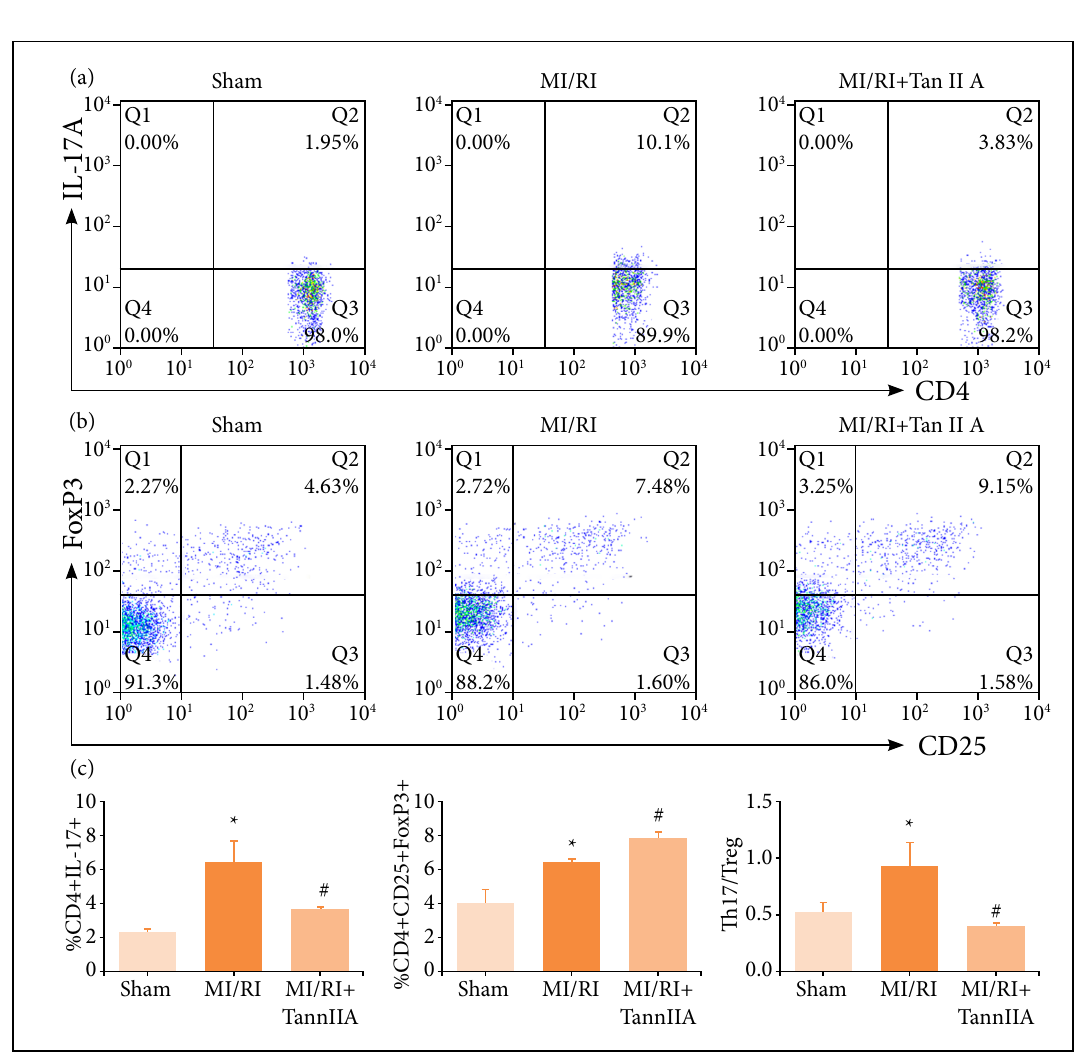
Figure 4 - Effect of tanshinone IIA on T cells differentiation in spleen. Representative flow samples of (a) CD4+IL17A+ cells and (b) CD4+CD25+FoxP3+ cells were shown from each sample. (c) Quantification of cell frequency of Th17 (CD4+IL17A+), Treg (CD4+CD25+FoxP3+) and Th17/Treg (n ≥